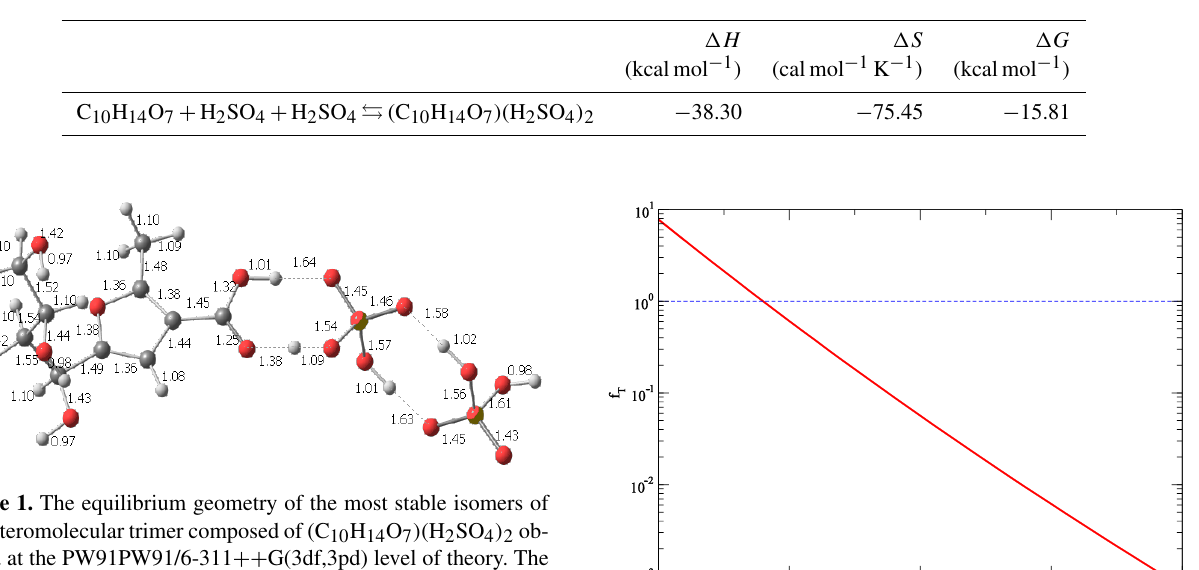
Table 1. The changes in enthalpy ( (cid:49)H ), entropy ( (cid:49)S ), and Gibbs free energy ( (cid:49)G ) for the formation of a (C 10 H 14 O 7 ) (H 2 SO 4 ) 2 cluster under the standard condition ( P = 1atm, T = 298K).